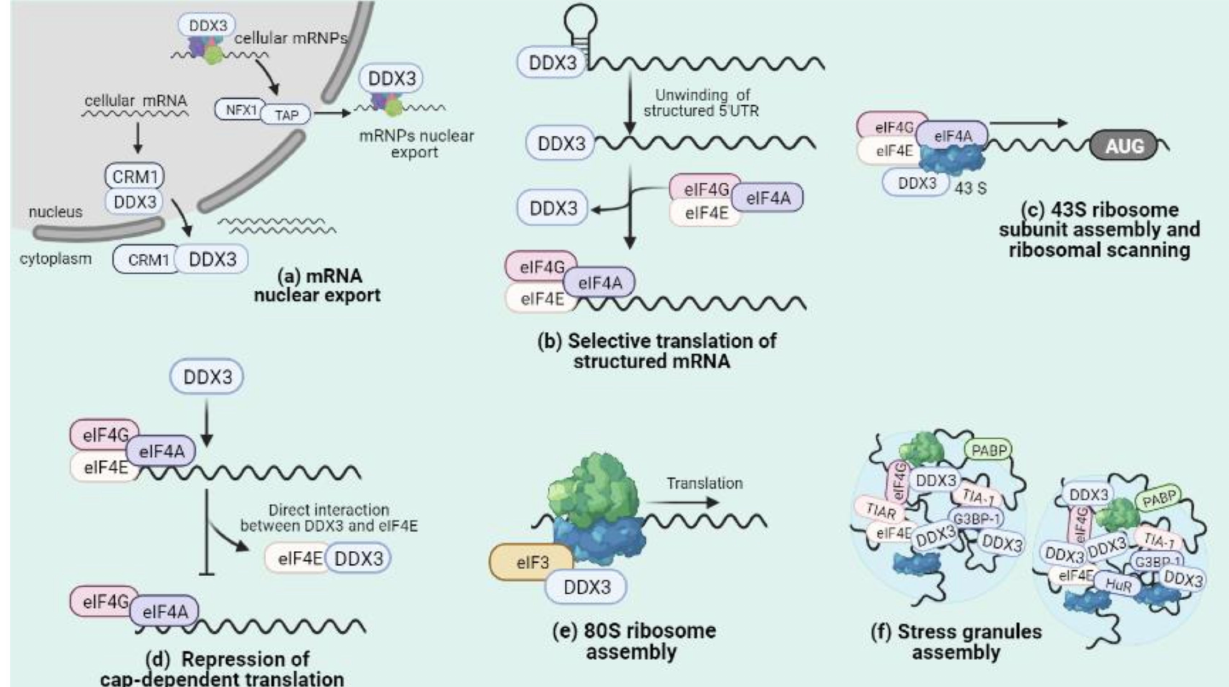
Figure 2. Roles of DDX3 in mRNA metabolism. ( a ) DDX3 participates in NXF1- and CRM1-driven nuclear export pathways to promote the cytoplasmic accumulation of specific subsets of mRNAs and mRNPs. ( b ) DDX3 promotes translation of mRNAs with structured 5 (cid:48) UTR in a helicase activity dependent-manner, through resolution of mRNA secondary structures near of 5 (cid:48) UTR. ( c ) DDX3 participates in 43S ribosome assembly and ribosomal scanning during translation initiation. ( d ) DDX3 interferes with cap-dependent translation through protein-protein interaction with eIF4E and promotes cap- independent translation. ( e ) DDX3 supports 80S ribosome assembly during translation initiation. ( f ) DDX3 is a component of stress granules that participates in their assembly and maturation through RNA-protein and protein-protein